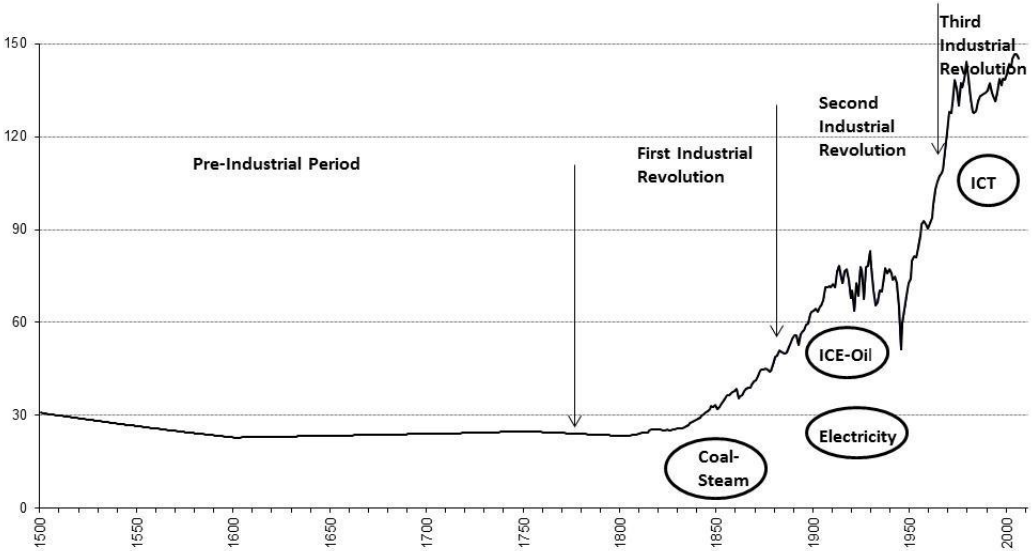
Figure 1. The long run energy consumption in Europe 1500–2010 in relation to three industrial revolutions (GJ per capita ). Source: [3] The sample includes Britain, France, Germany, Italy, the Netherlands, Portugal, Spain, and Sweden. The circles indicate the main technological influences on the changes in energy use associated with each revolution. There was also some continuity from older developments during these